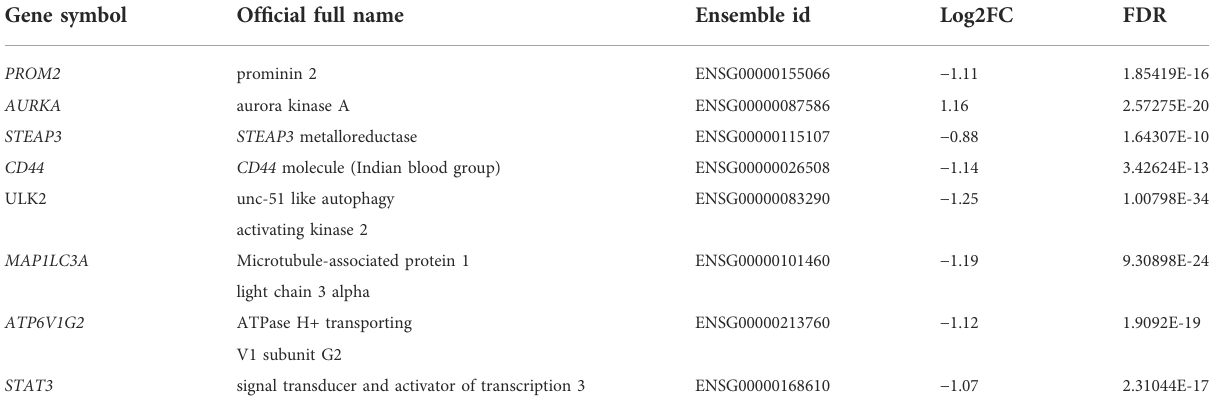
TABLE 2 FRGs in the prognostic